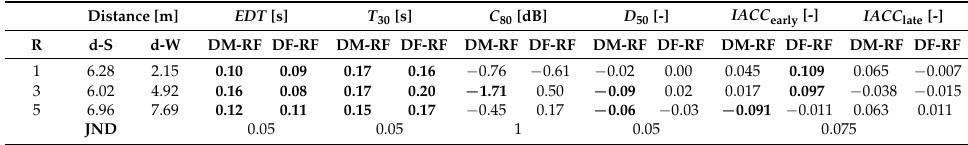
Table 3. Differences of the objective acoustic parameters between the DM and RF simulations and DF and RF simulations in position 1, 2, and 3. Differences higher than one JND have been highlighted in bold. The differences are between mean values at 500–1000 Hz ( EDT, T 30 , C 80 , D 50 ) and 500–2000 Hz ( IACC early and IACC late